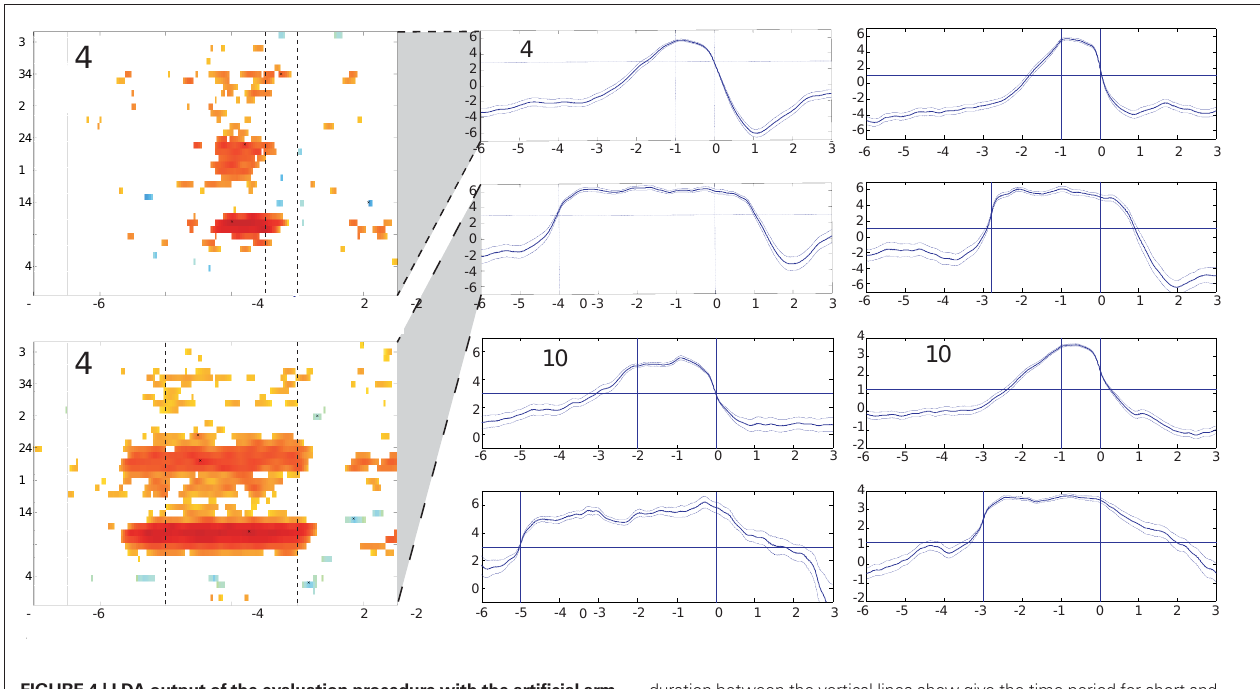
Figure 4 | LDA output of the evaluation procedure with the artificial arm. Averaged LDA output ( ± standard error) of four subjects for short (upper) and long (lower) switches are given in the panels at the right. The horizontal line represents the threshold to be exceeded for the duration detection. Time